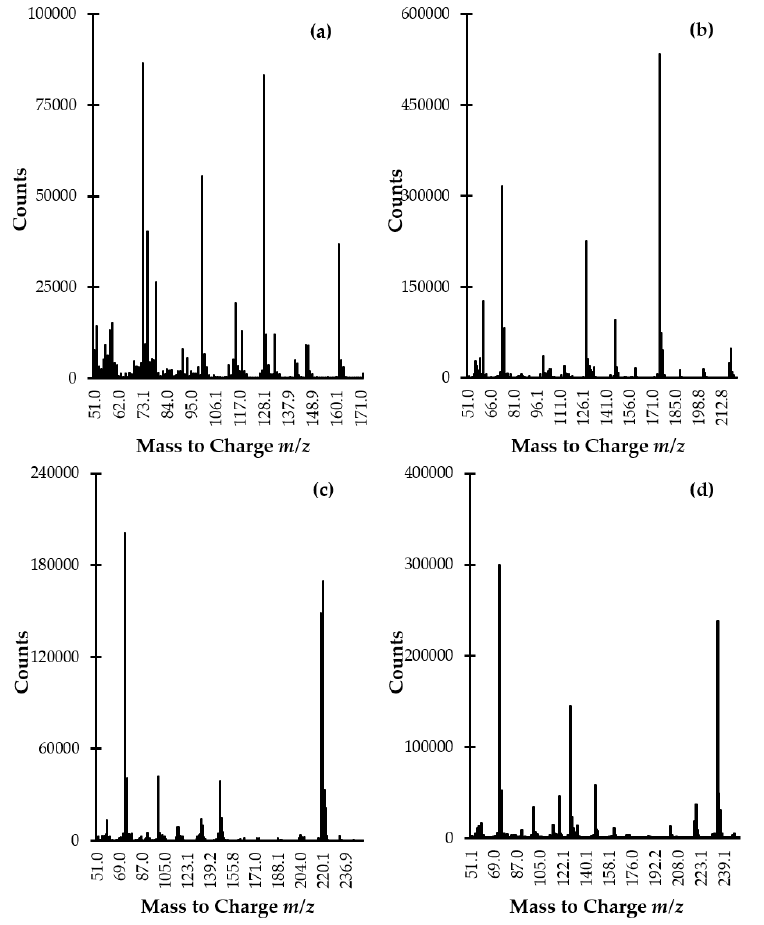
Figure 4. EI scan mode mass spectra of ( a ) HTL-, ( b ) Met-, ( c ) Cys-, and ( d ) Hcy-TMS derivatives obtained by analyzing standard solution of Met, Hcy, HTL, and Cys (100 µmol L −1 ) prepared according to the procedure described in Section 3.5.